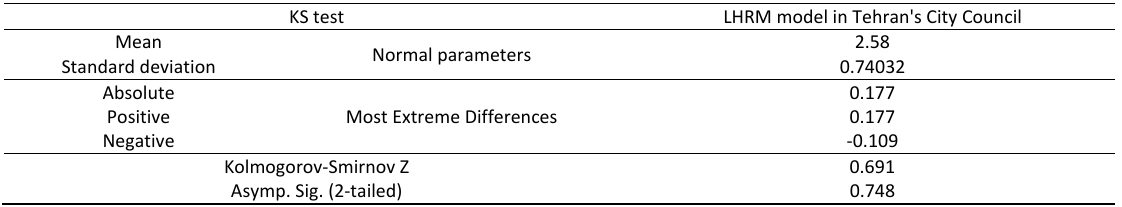
Table 2: The results of the KS test to check the distribution normality of the questionnaire